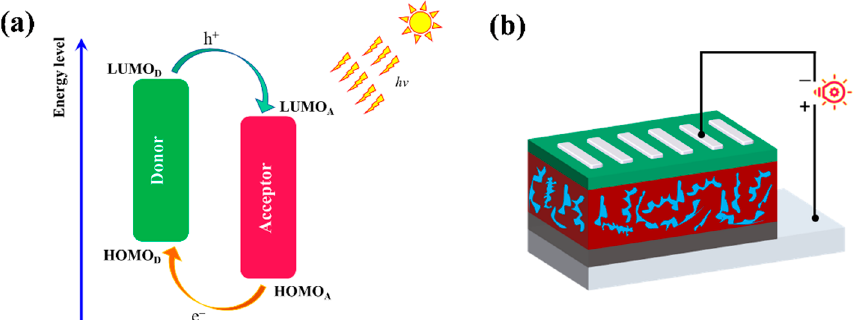
Figure 6. ( a ) Schematic illustration of the energy levels at the interface of polymer/ITIC pair in PSCs. ( b ) Device structure. Table 1. The optimized geometry of oligomers: dihedral angles ( θ ) of the D-A block, energies of HOMO, LUMO, E g values, and V OC .